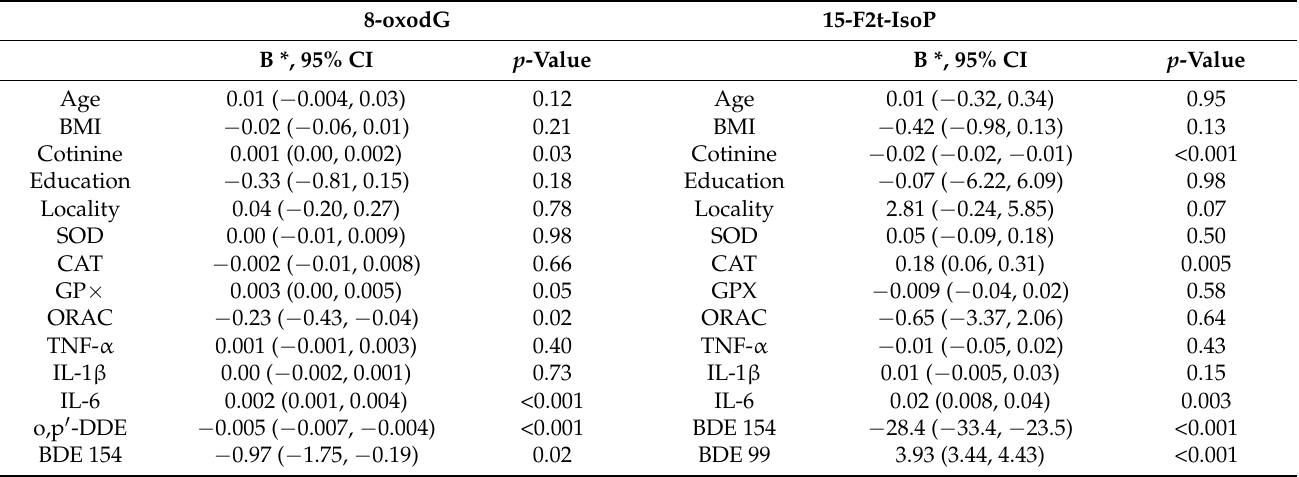
Table 5. Multivariate estimates of associations between oxidative stress markers and selected parameters. 8-oxodG